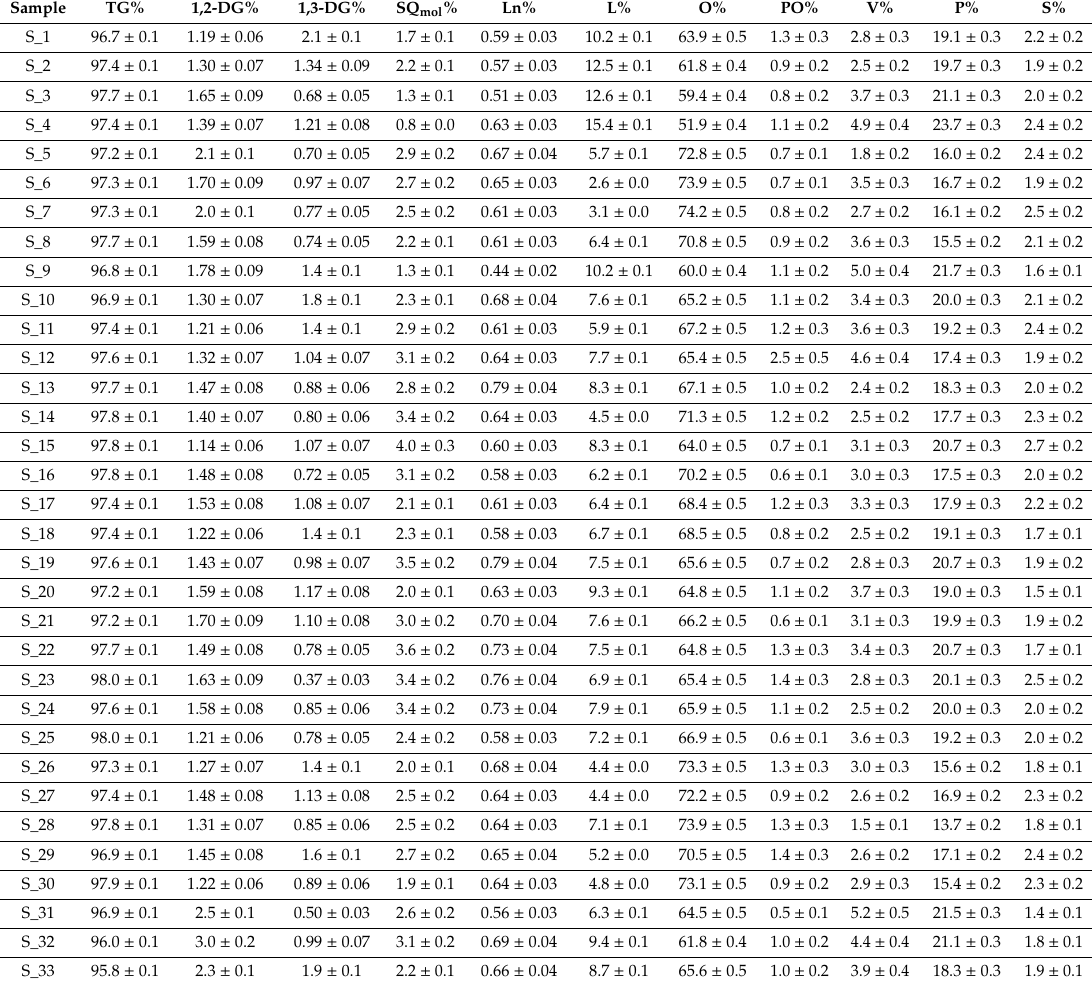
Table 2. Quantitative data and relative deviation for 11 main variables (whose code is reported in Table 1), as measured through Multi-Assignment Recovered Analysis-Nuclear Magnetic Resonance (MARA-NMR) processing method working on mono dimensional 1 H and 13 C-NMR experiments for 33 samples. Standard deviations were measured through 9 di ff erent experiments on 3 identical samples analyzed on three di ff erent